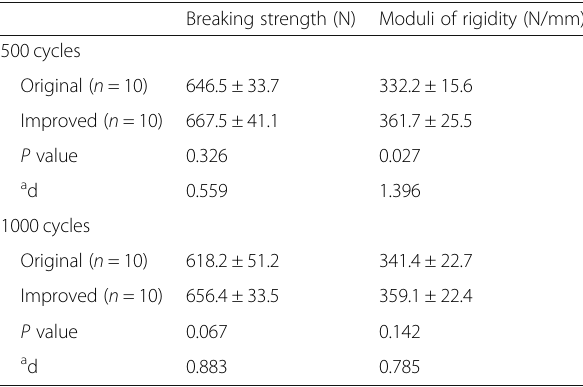
P value by two sample paired t-test a d: Effect size by Cohen ’ s